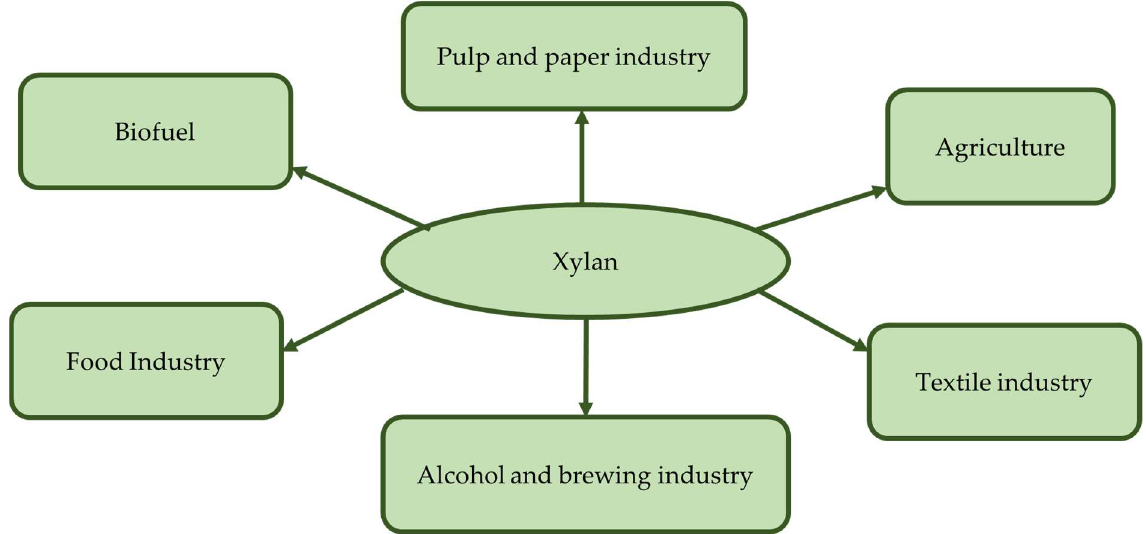
Figure 2. Industries using xylan.